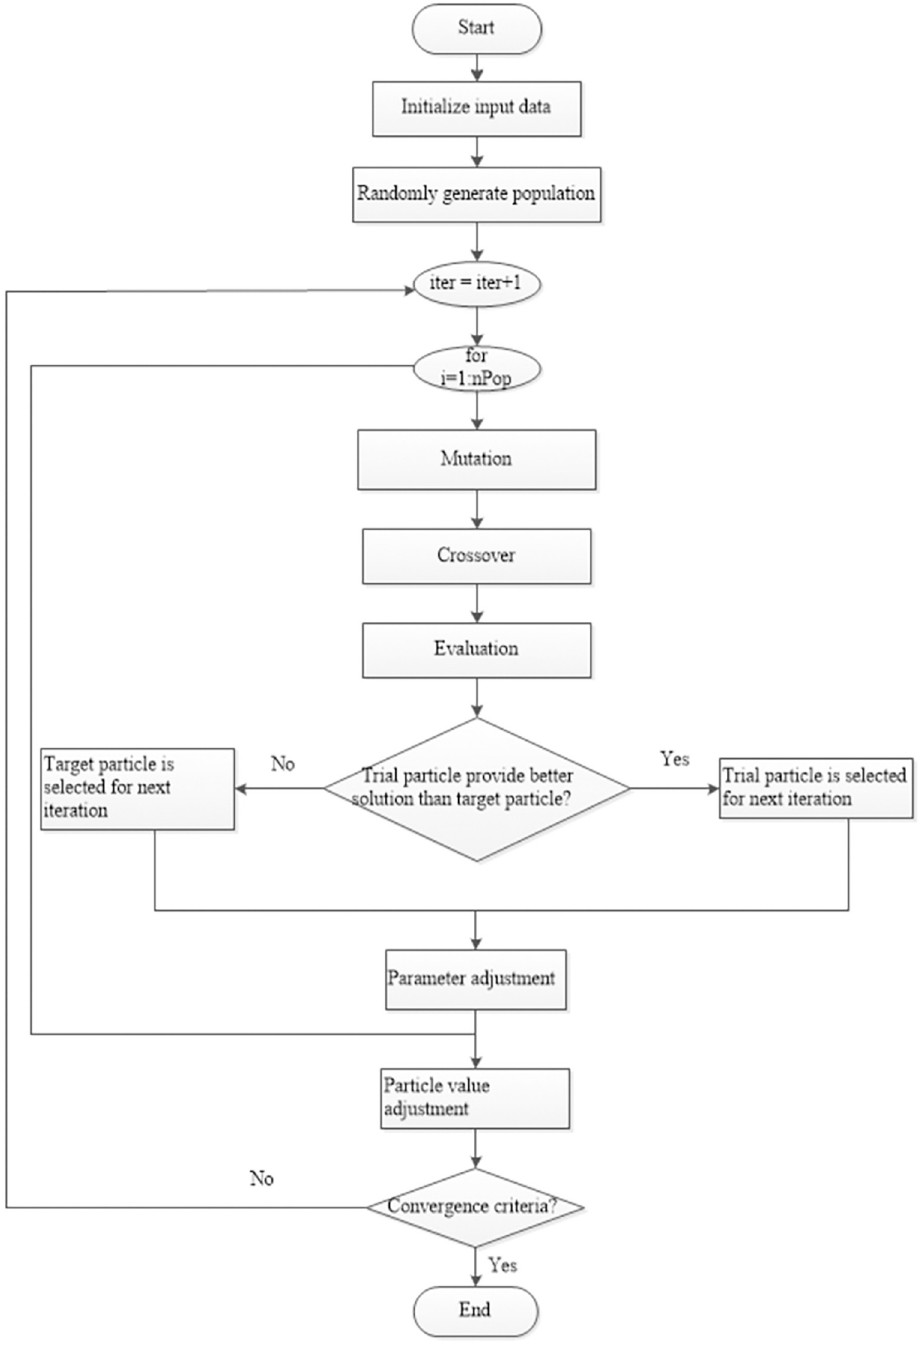
Fig 9. The MOEPSO